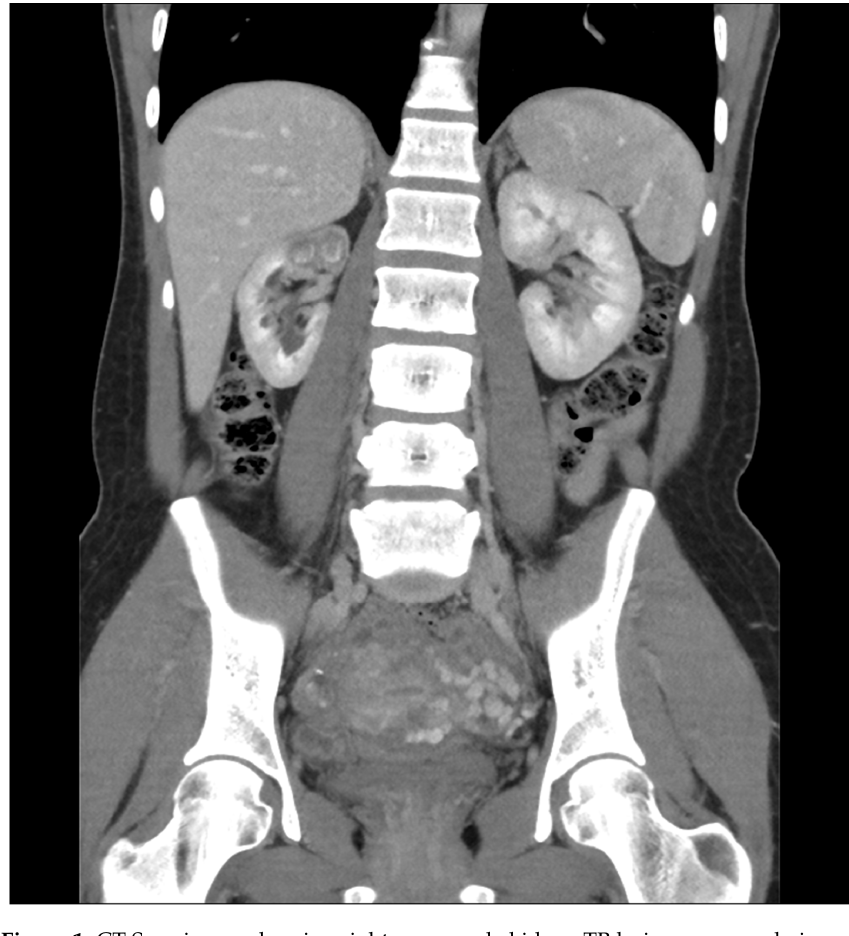
Figure 1. CT Scan image showing right upper pole kidney TB lesions—coronal view.